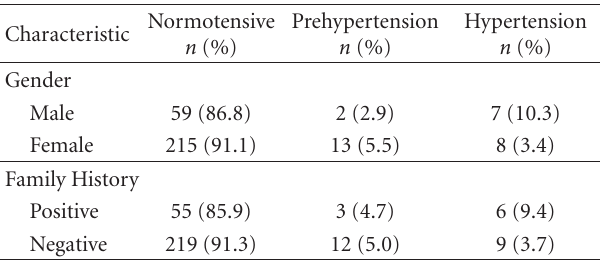
Table 2: Gender and family history of hypertension by blood pressure category.